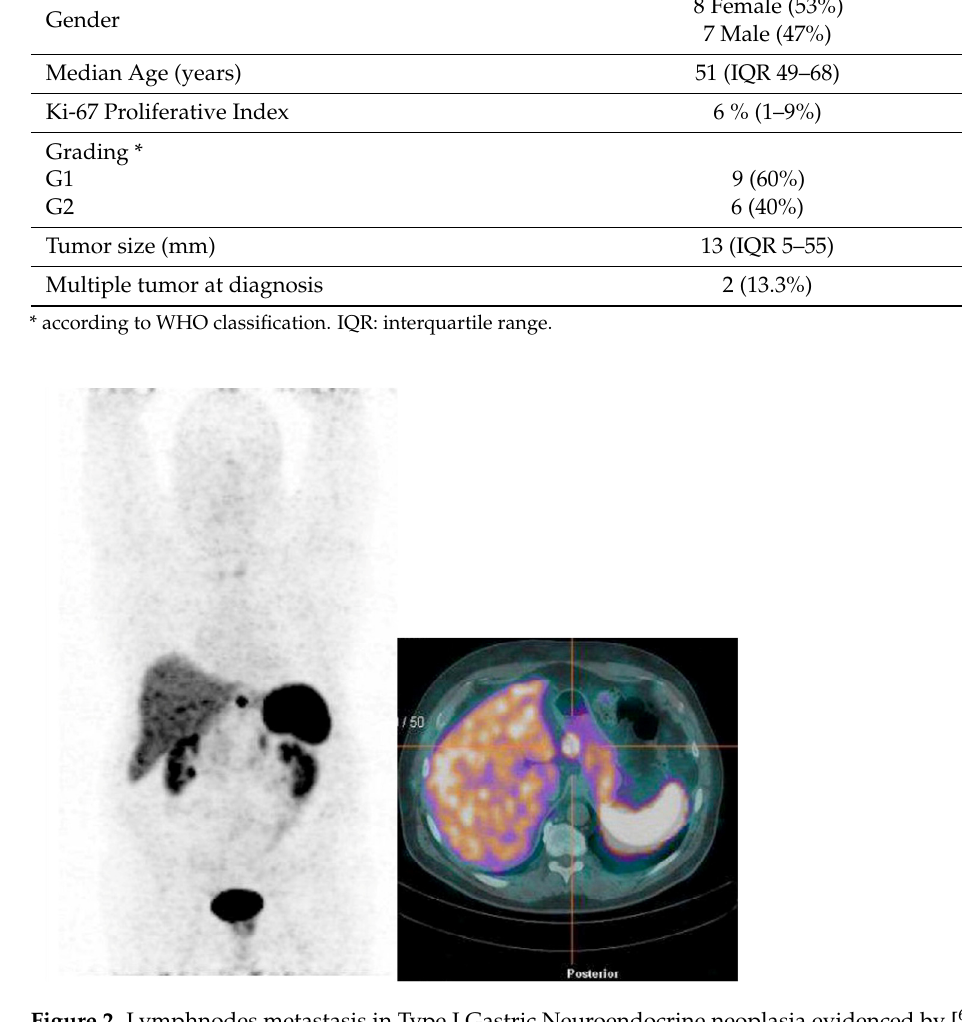
Figure 2. Lymphnodes metastasis in Type I Gastric Neuroendocrine neoplasia evidenced by [68Ga]Ga-DOTA-SST PET/CT.